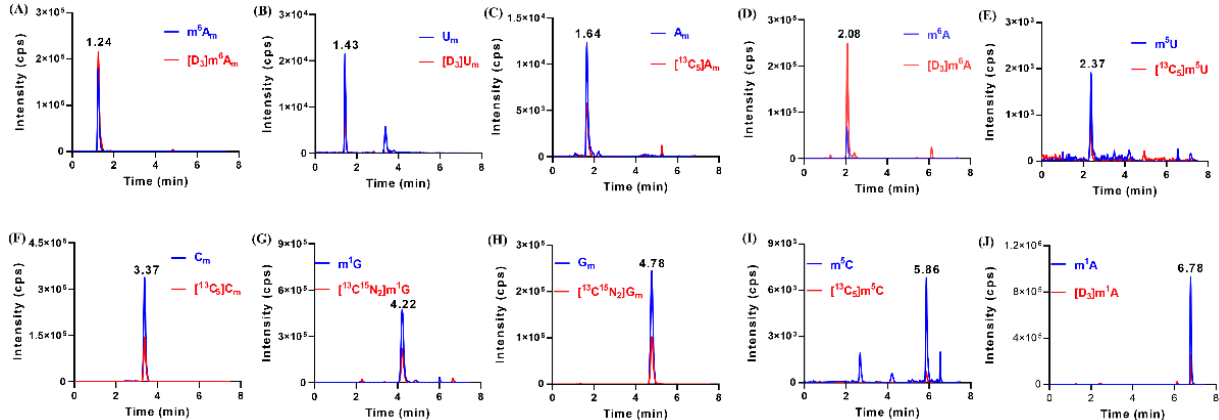
Figure 3. Representative multiple reaction monitoring (MRM) chromatograms of ( A ) m 6 A m , ( B ) U m , ( C ) A m , ( D ) m 6 A, ( E ) m 5 U, ( F ) C m , ( G ) m 1 G, ( H ) G m , ( I ) m 5 C, and ( J ) m 1 A and spiked isotope-labeled internal standards in a urine sample.